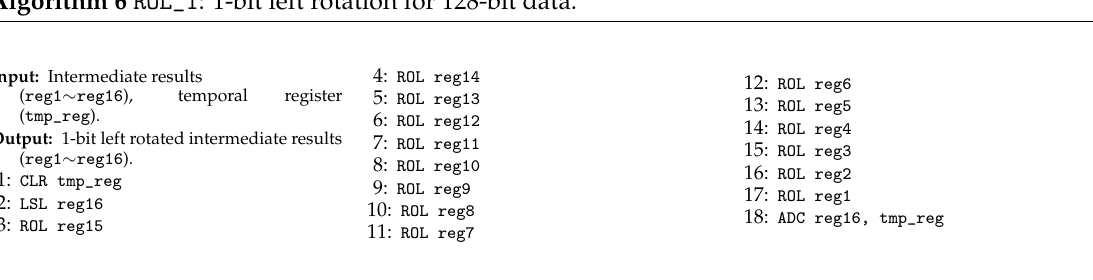
Algorithm 6 ROL_1 : 1-bit left rotation for 128-bit